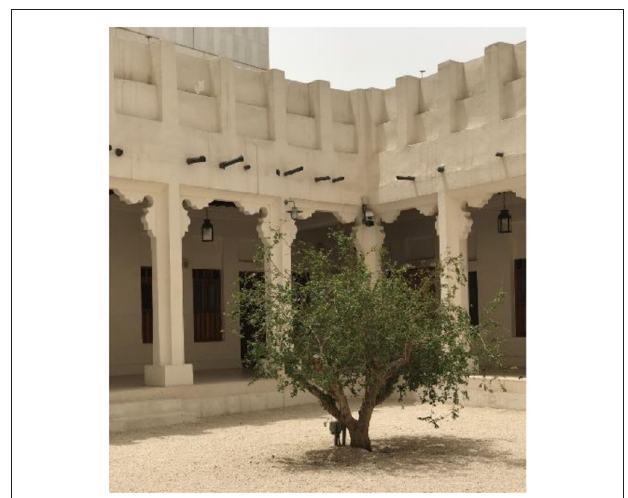
FIGURE 1 | A traditional courtyard was a primary feature in Qatari houses that surrounded the open sitting area Liwan .